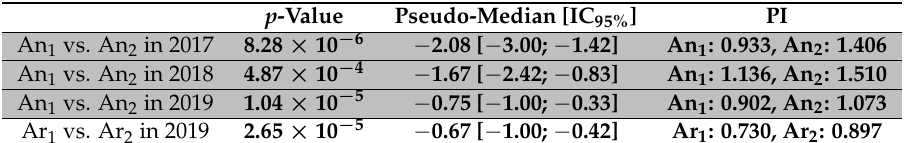
Table 1. Wilcoxon Signed Rank bilateral tests for paired samples on the intra-site level. p -values have been corrected by the FDR method and are shown in Figure 3. The pseudo-medians of the daily activity hours differences and their 95% confidence interval as well as the associated persistence indices (PI) are also presented. Significant differences are in